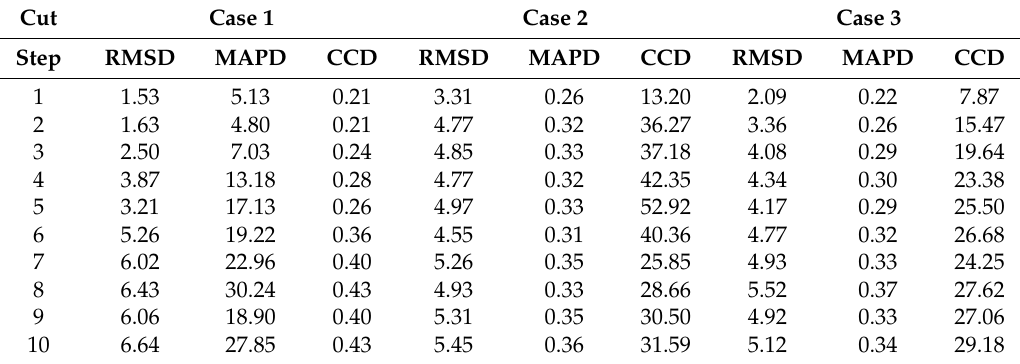
Table 1. RMSD, MAPD and CCD values (%) calculated for conventional PZT attachment method. Cut Case 1 Case 2 Case 3